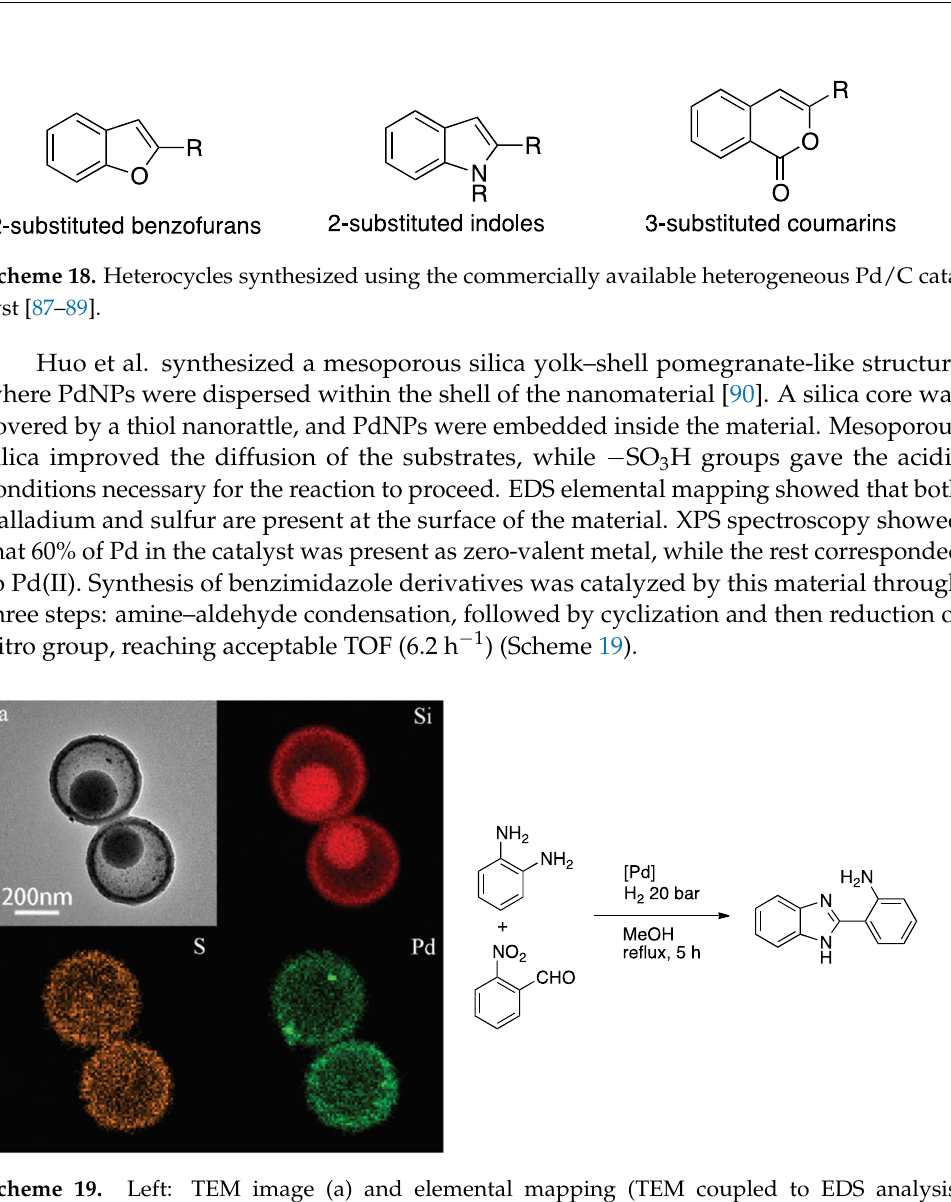
Figure 7. TEM image of Pd@CN and four-component synthesis of triarylpyrazoles [91]. Repro- duced from [91] with permission from the American Chemical Society.